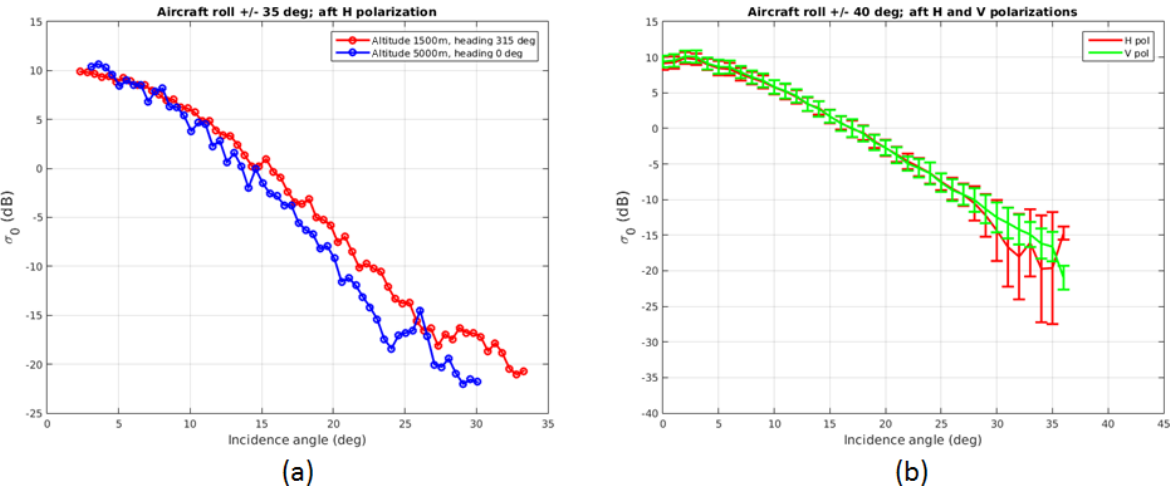
Figure 3. Radar cross section of the surface ( σ 0 ) as a function of incidence angle: (a) measured σ 0 from H polarization over water surface with different wind direction from the 29 March 2016 calibration flight. Gas attenuation and water vapour corrections have not been applied, since the flight in question was performed at a sufficiently low altitude in clear air condition. As a result, the effects of water vapour and gas attenuation are minimal. There is a cross point at incidence angle of around 10 ◦ and σ 0 of 5.85dB. (b) σ 0 from both horizontal and vertical polarizations for 4 March 2017 flight shows a good polarimetric calibration.